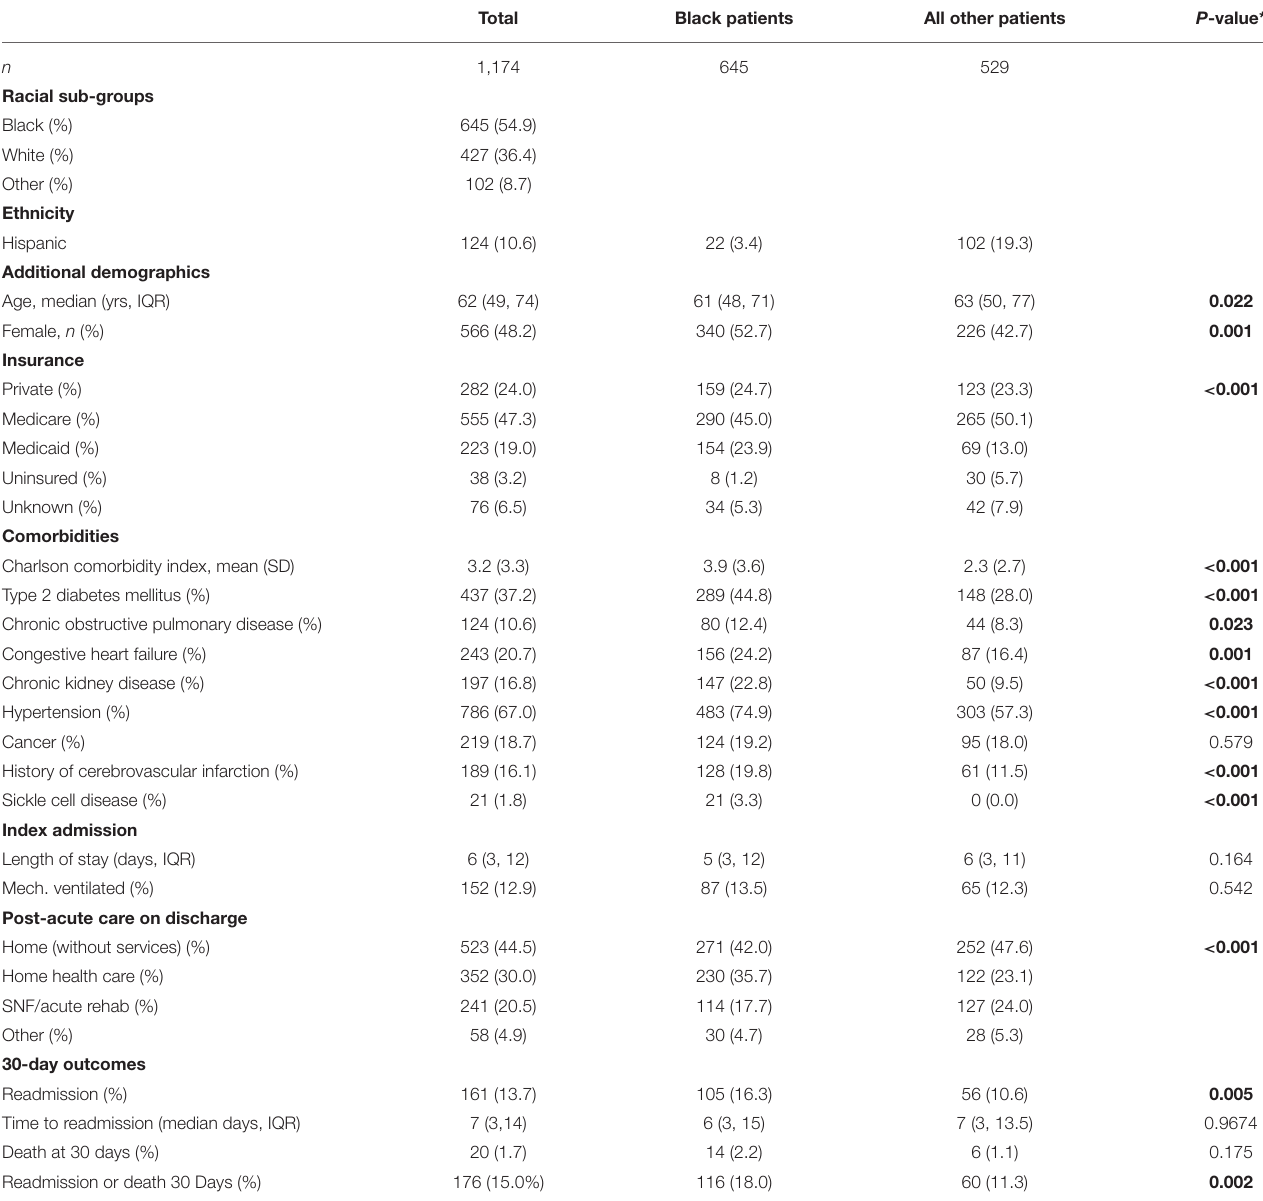
TABLE 1 | Characteristics of Black and Non-Black patients by site of discharge following index admission for COVID-19. Total Black patients All other